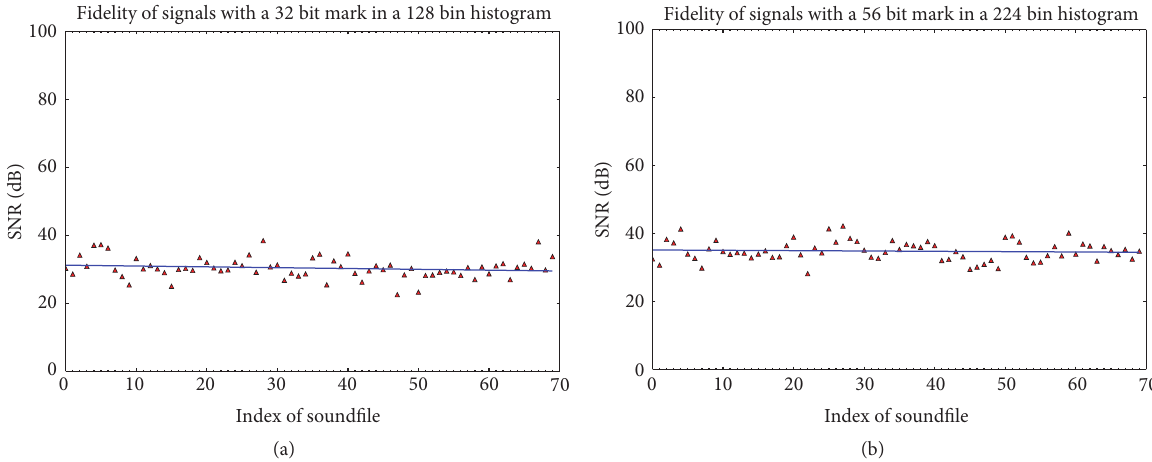
Figure4:Impactofdifferentparameterchoicesonperceptibility.(a)32bitwatermark, 𝐿 𝐵 = 128 .AveragePSNRis32 dB;(b)56bitwatermark, 𝐿 = 224 . Average PSNR is 38 𝐵